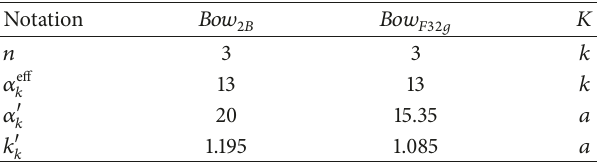
Table 9: Values of the empirical coefficients in (25) for the curvature blading ( 𝑎 =